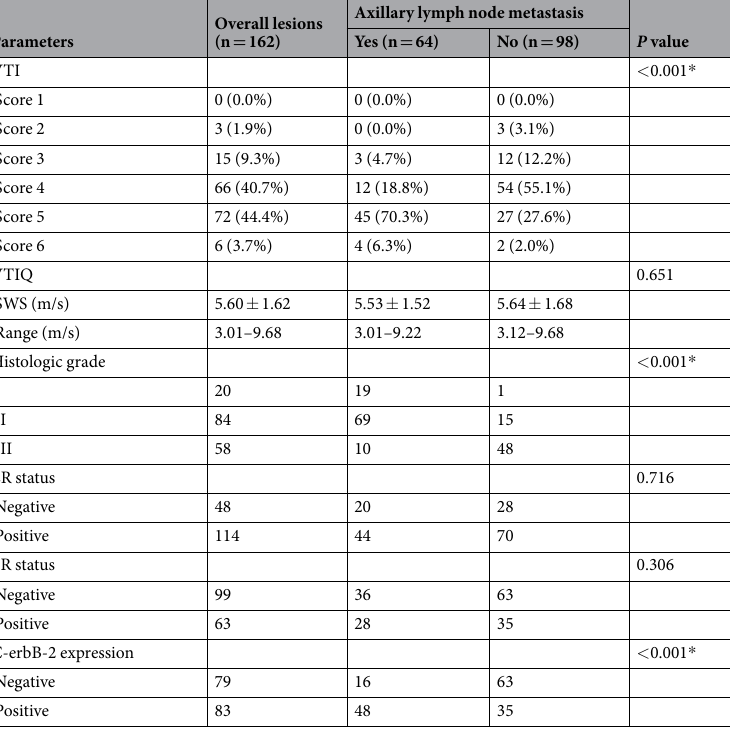
Table 2. Comparisons with VTI, VTIQ, and histologic parameters between breast lesions with axillary LNM and those without axillary LNM. VTI virtual touch tissue imaging, VTIQ virtual touch tissue imaging